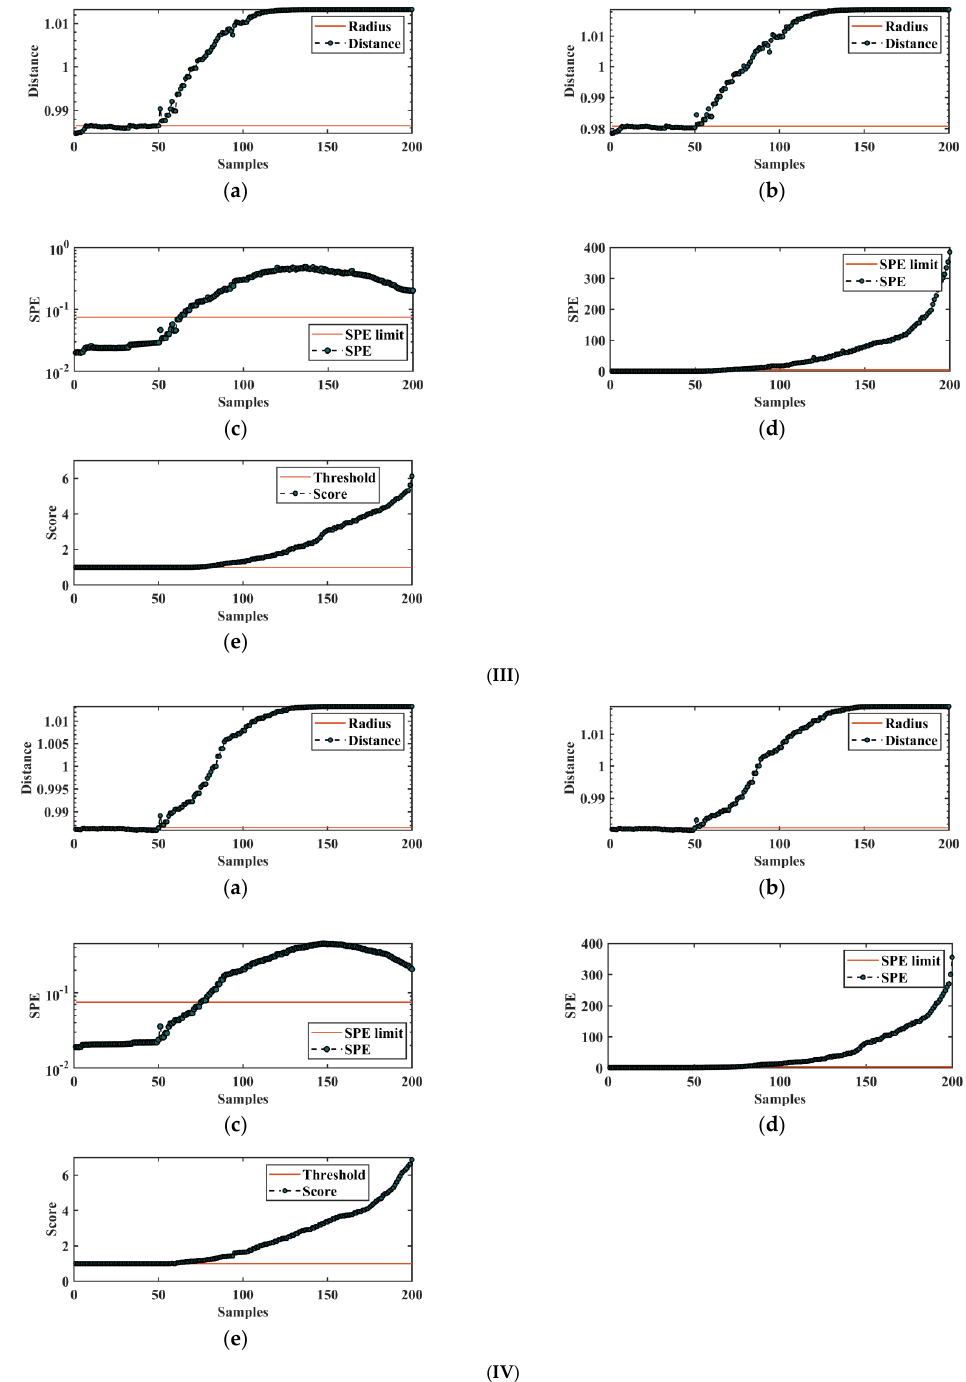
Figure 11. ( I ) The msf fault detection results of four models: ( a ) BO-SVDD detection results; ( b ) SVDD detection results; ( c ) KPCA detection results; ( d ) PCA detection results; and ( e ) LOF detection results. ( II ) The csf fault detection results of four models: ( a ) BO-SVDD detection results; ( b ) SVDD detection results; ( c ) KPCA detection results; ( d ) PCA detection results; and ( e ) LOF detection results. ( III ) The ocf fault detection results of four models: ( a ) BO-SVDD detection results; ( b ) SVDD detection results; ( c ) KPCA detection results; ( d ) PCA detection results; and ( e ) LOF detection results. ( IV ) The odf fault detection results of four models: ( a ) BO-SVDD detection results; ( b ) SVDD detection results; ( c ) KPCA detection results; ( d ) PCA detection results; and ( e ) LOF detection